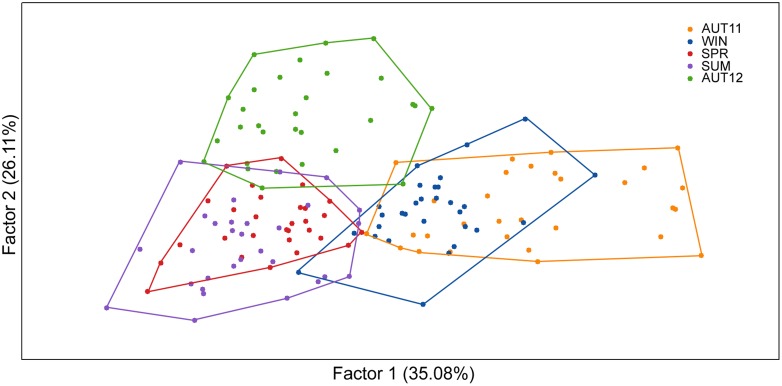
Factorial correspondence analysis of allelic temporal variation.Each polygon represents the multilocus genetic variation of each chronological sample. Between brackets, the relative contribution of each factor (accounted for 61.19% of the total variation).